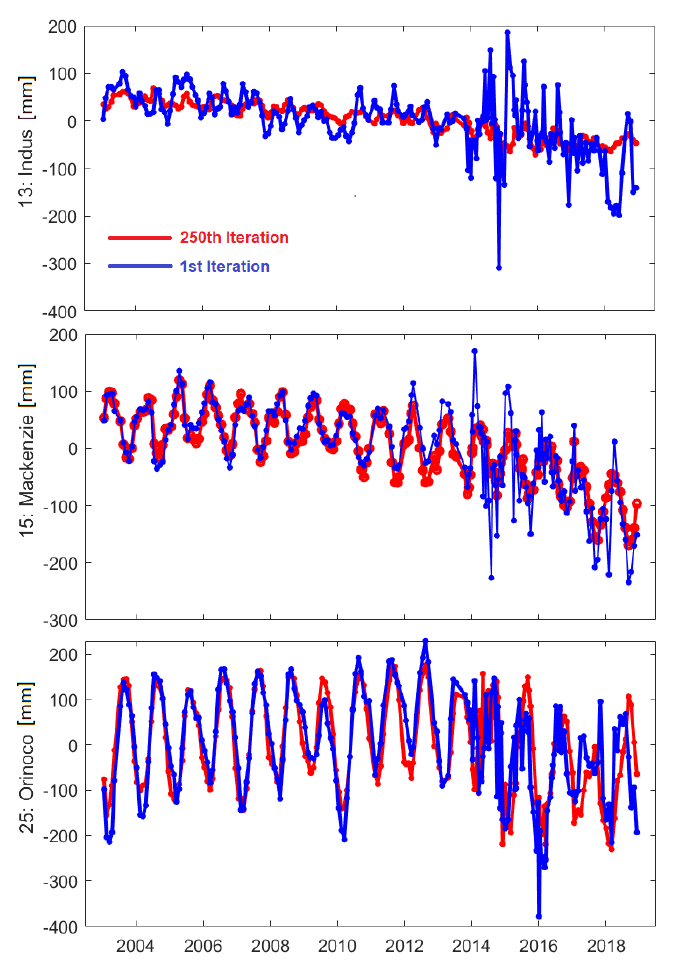
Figure A1. A comparison between basin averaged TWSC estimations derived from the iteration 1 and 250 of the reconstruction-Approach 2. The results are shown for three arbitrary selected river